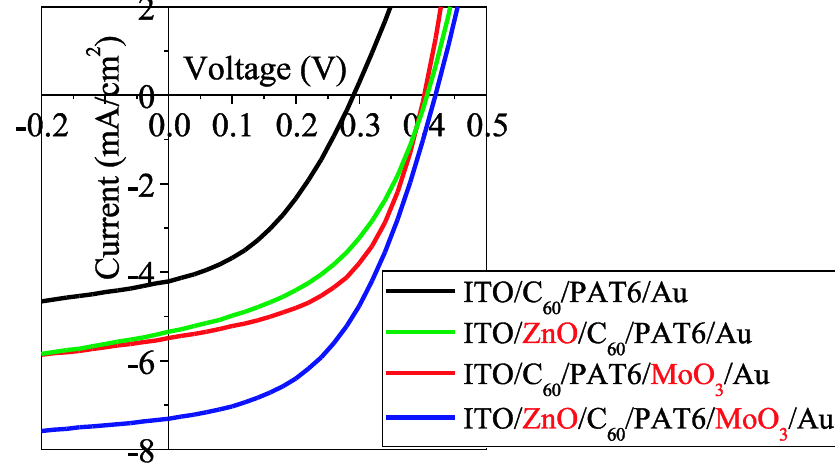
Figure 4. Current-voltage characteristics of the solar cells with no buffer layer, the MoO buffer layer (6 nm), the ZnO buffer layer (50 nm), and the MoO (6 nm and 50 nm, respectively) under AM1.5 (100 mW/cm 2 ) solar-illuminated conditions.